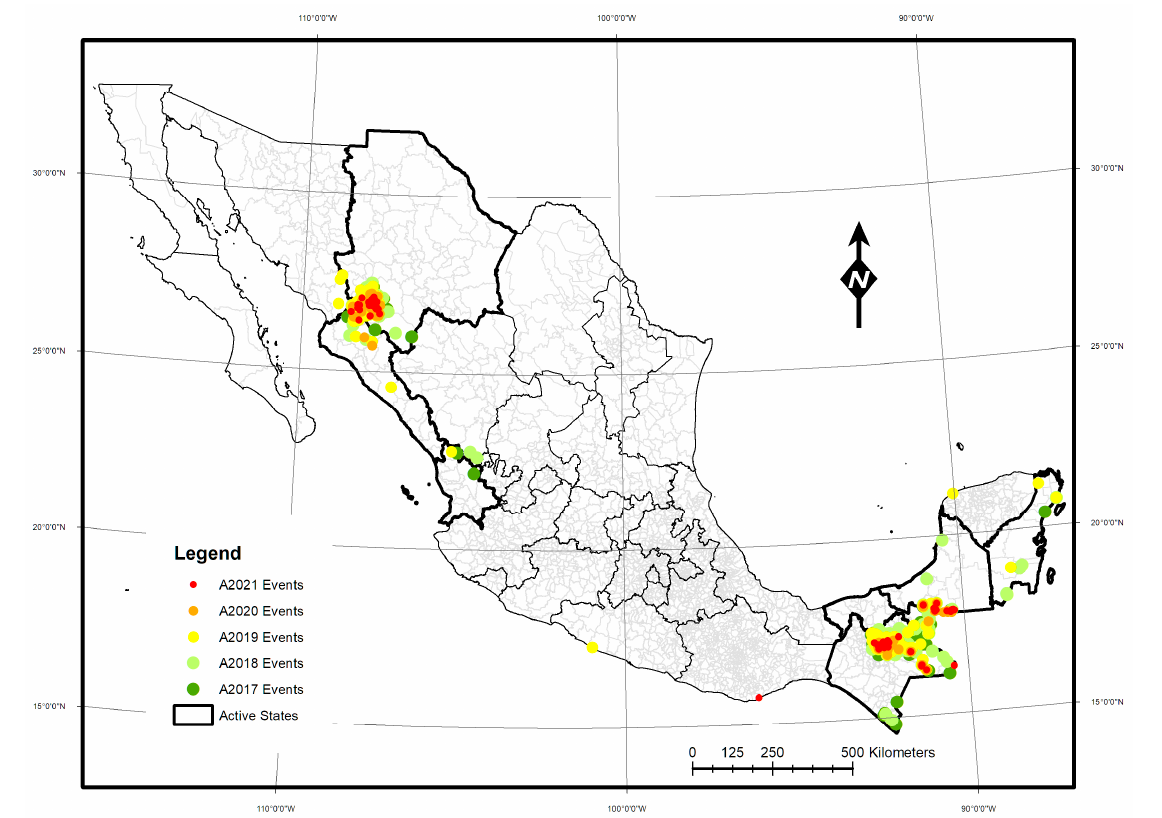
Figure 1. Confirmed cases of malaria from 2017 to 2021.